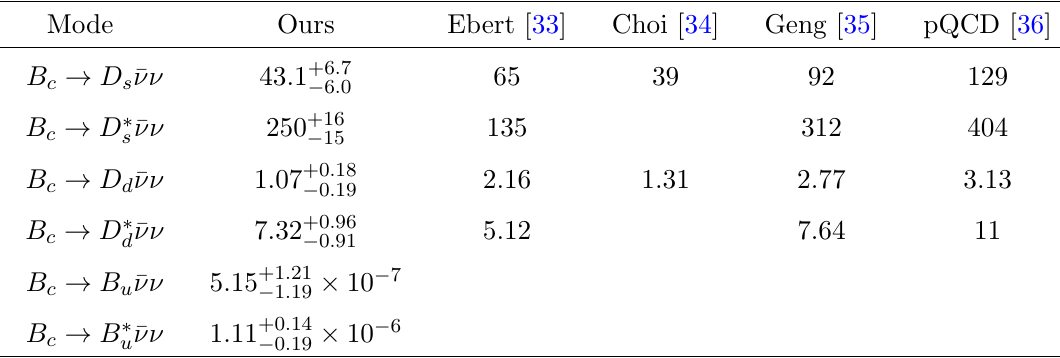
(cid:0) 8 c decays (in units of 10